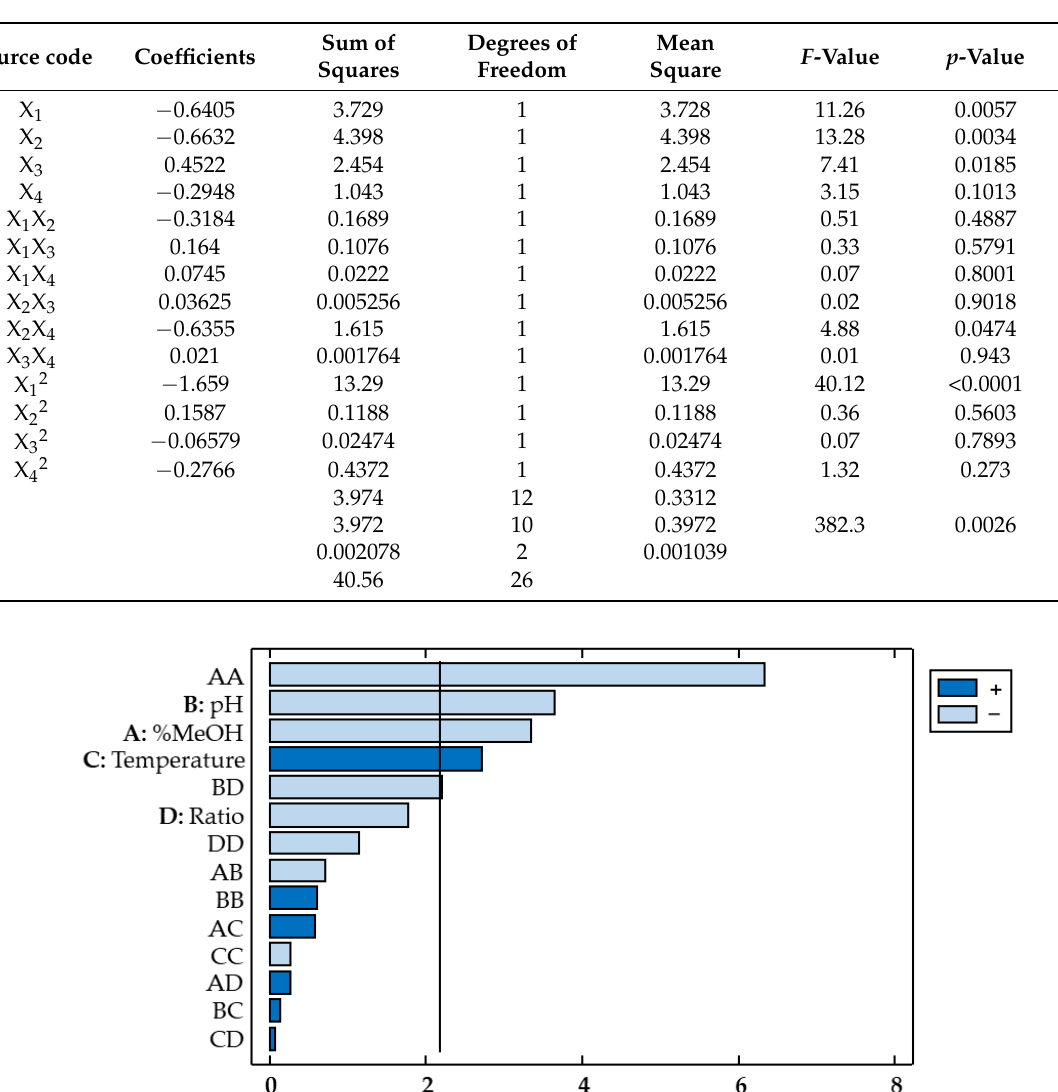
Table 4. ANOVA of the response variable antioxidant activity (Y DPPH ).